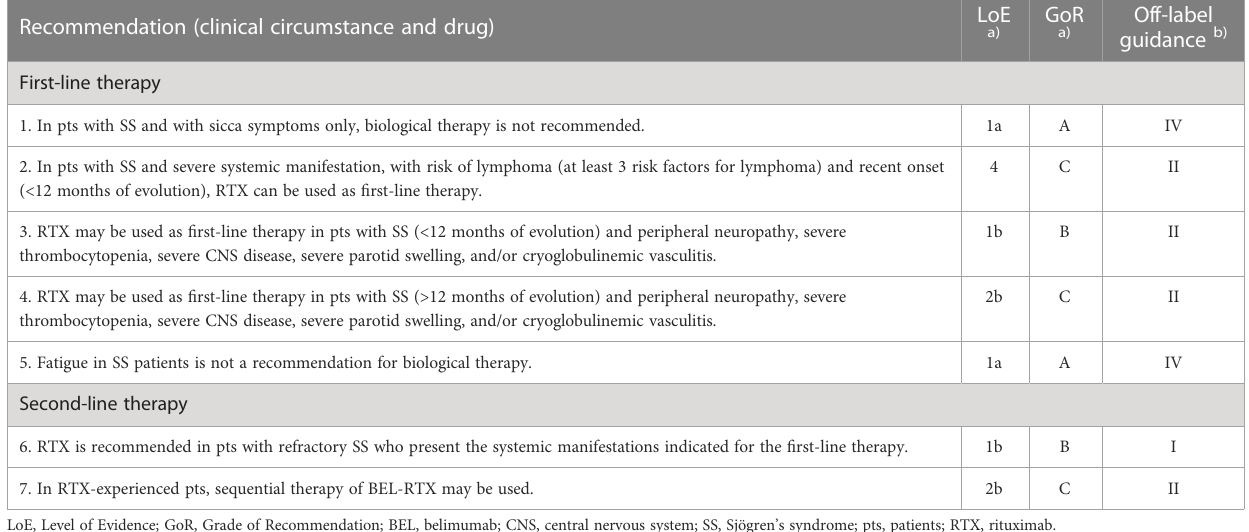
Recommendation (clinical circumstance and